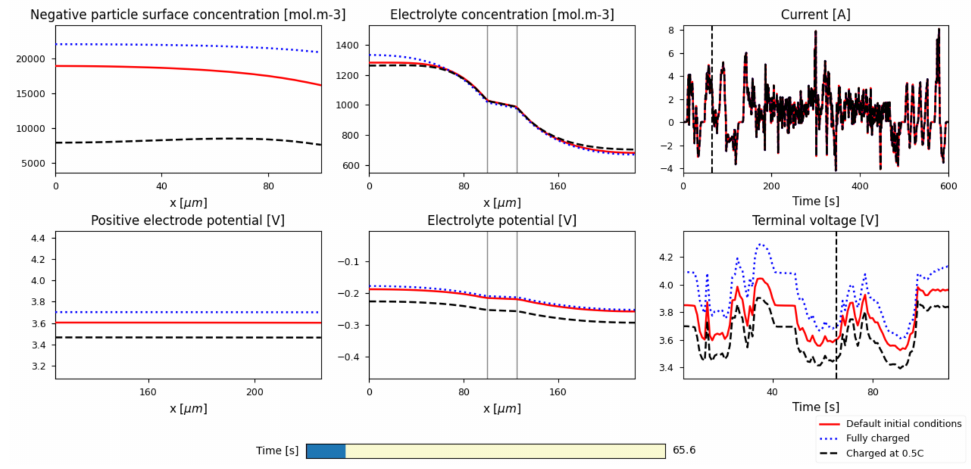
Figure 4. DFN model discharge results with different preconditions. Fully charged—code statement